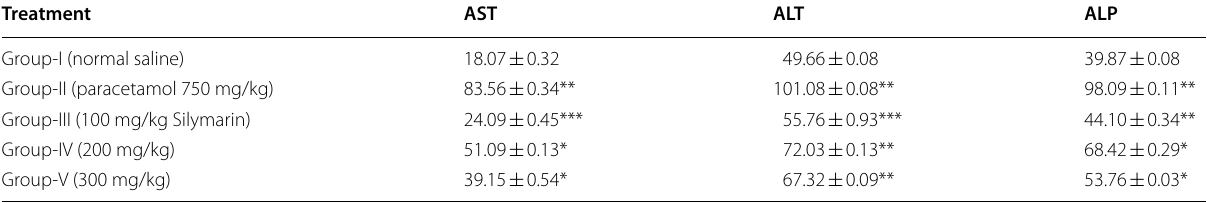
Table 3 Effect of ethanolic extract of L. rugosa on liver function enzymes in paracetamol-induced hepatotoxicity in